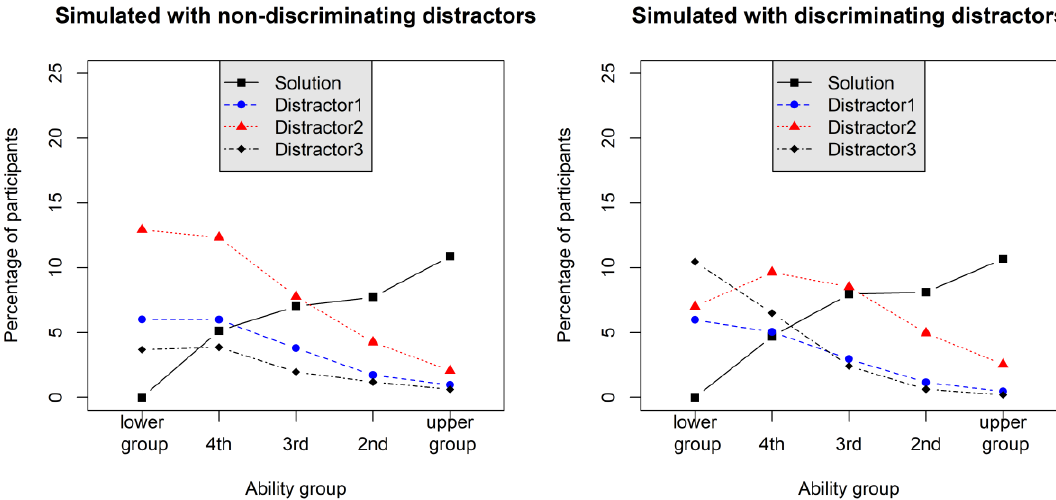
Figure 1. Trace line plots (Gierl et al. 2017; Wainer 1989) of two simulated items ( N = 10,000 each) when distractors were simulated as non-discriminating in a 2PL (left plot) and when distractors were simulated with moderate NRM (nominal response model) discrimination in a 2PNL.